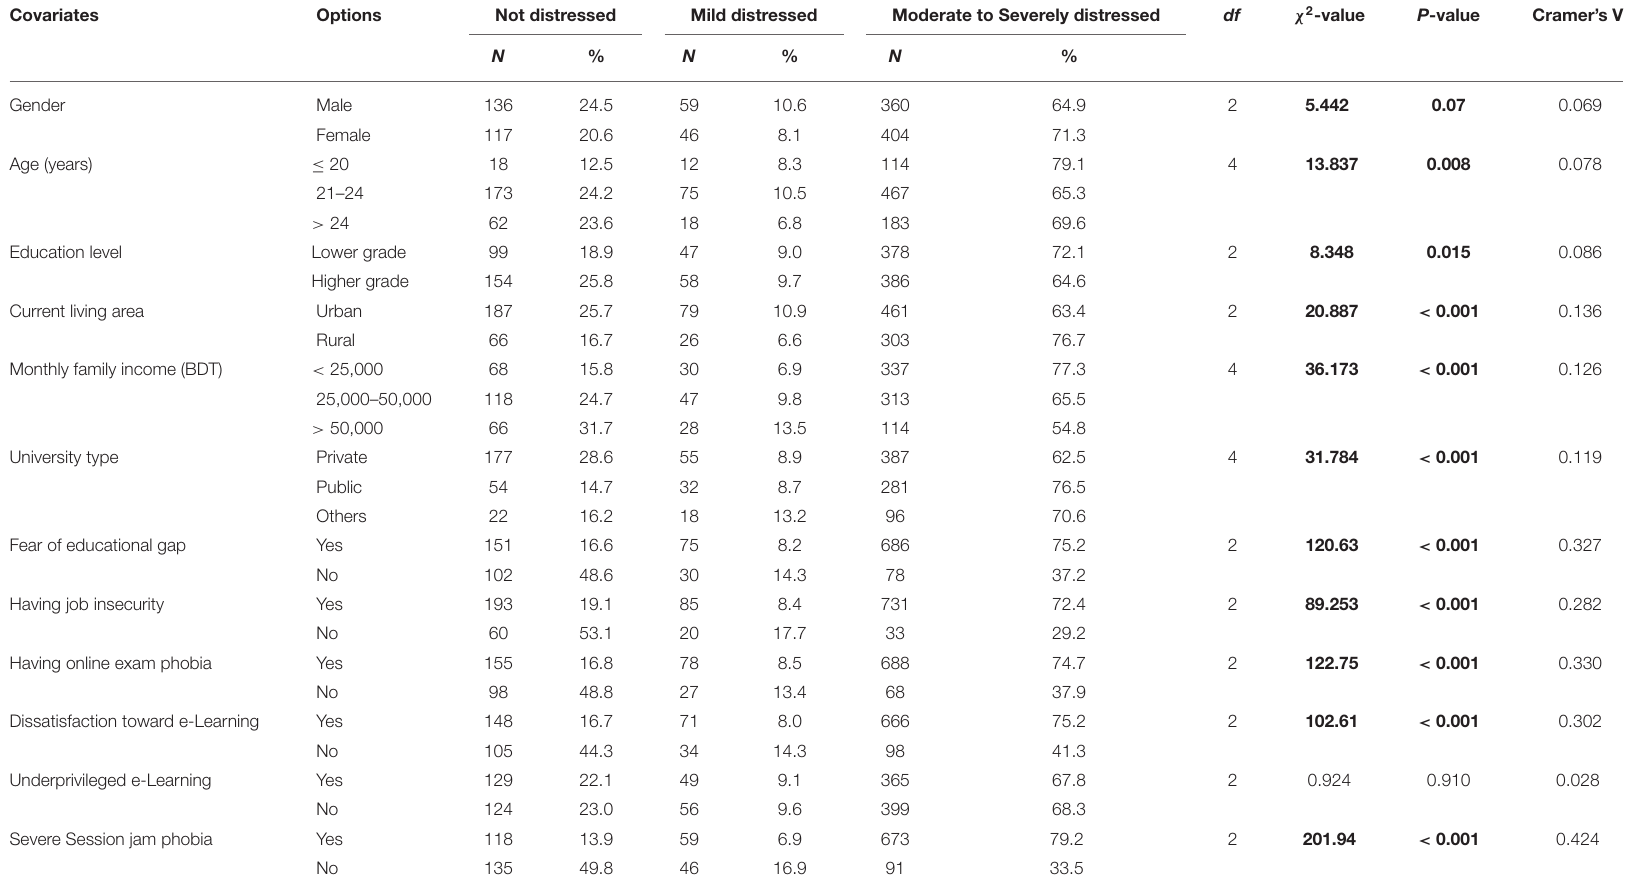
The bold values indicate the statistically significant